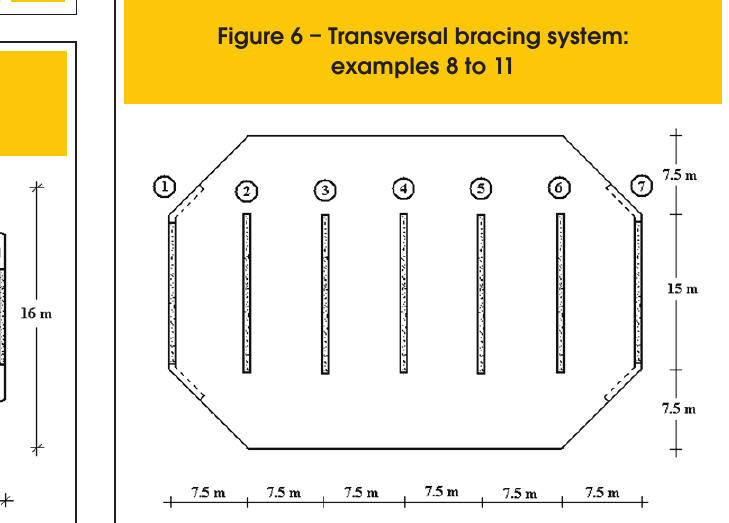
Figure 6 – Transversal bracing system: examples 8 to